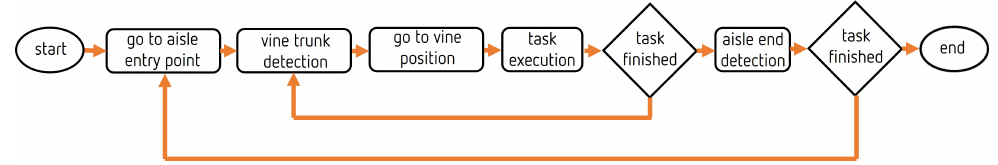
Figure 7. High-level task flow of vine trunk-based navigation for autonomous vineyard task ex- ecution. After entering a new aisle, the ATMM positions itself next to the next vine trunk in the aisle. The robot performs the desired task and moves to the next vine trunk. At the end of the aisle, the robot moves to the next aisle. The process is repeated until the mission is